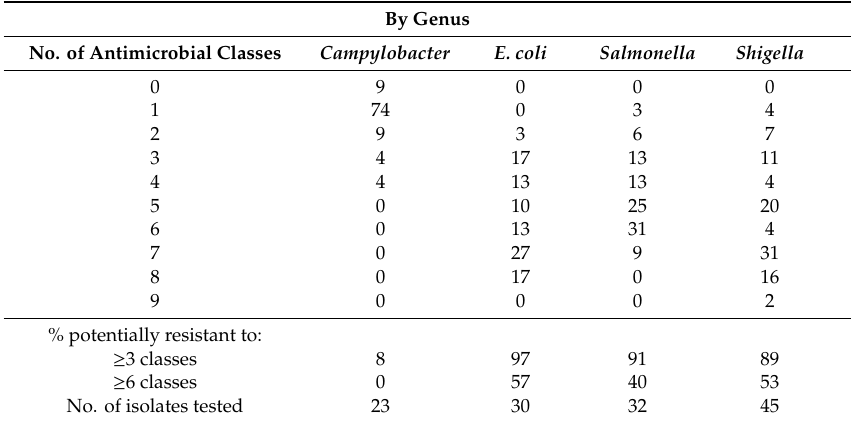
Table 1. Percentage of isolates with potential resistance to multiple classes of antimicrobial compounds based on their microarray profiles.